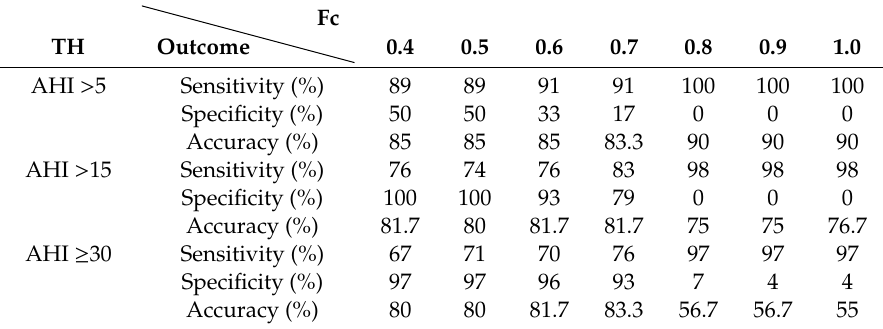
Table 3. Analysis of detection accuracy among all enrolled